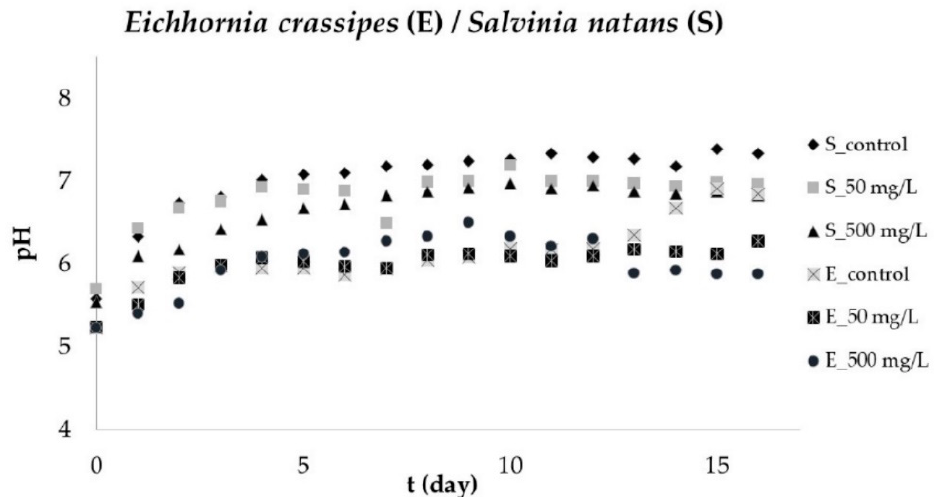
Figure 4. Dye solution pH change.